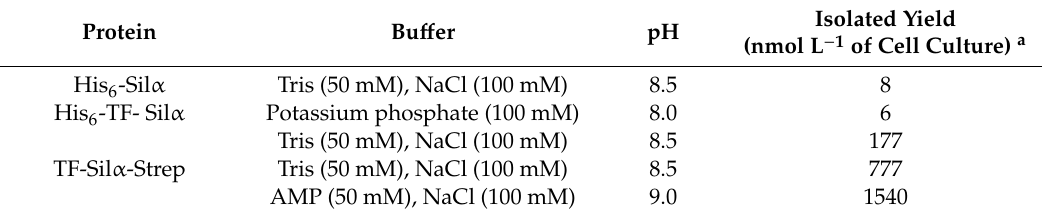
Table 4. Comparative summary of protein production yields for the Sil α fusion proteins. Protein